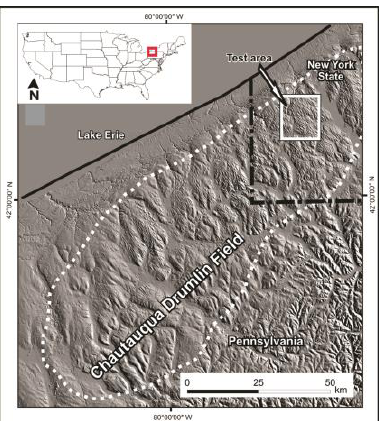
Figure 1. Location of the terrestrial drumlin field in the USA;